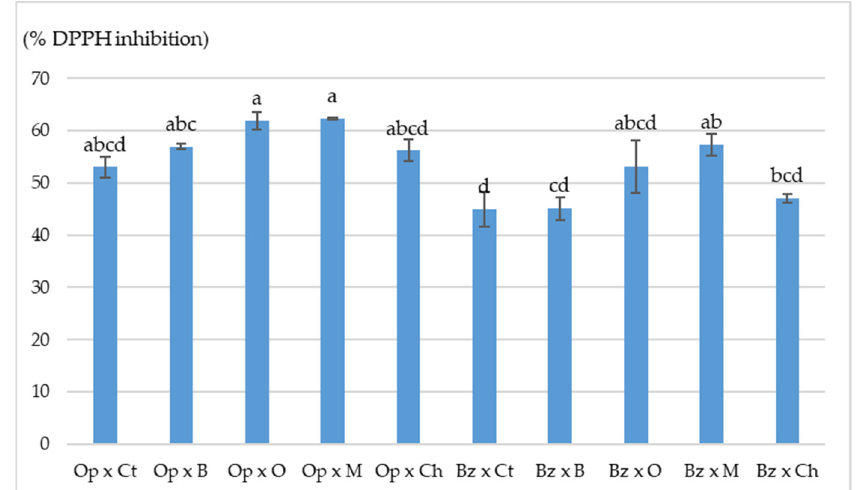
Figure 5. Antioxidant activity in basil leaves, as affected by the interaction between cultivar and fertilization. Opal (Op); De Buzau (Bz); control (Ct); biosolids (B); organic (O); microorganisms (M); chemical (Ch). Values associated with different letters are significantly different according to Tukey’s test at p < 0.05.